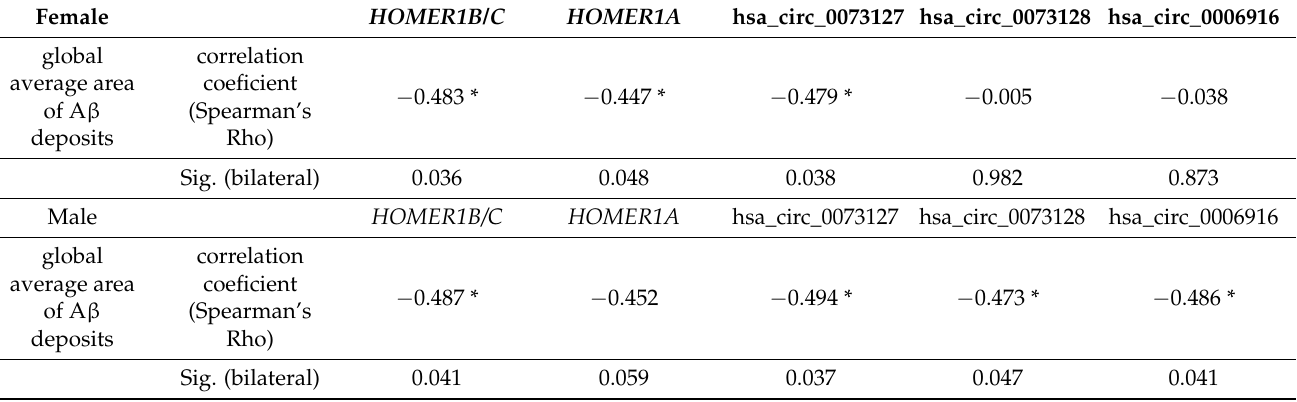
Table 2. Correlation between global average area of A β deposits and HOMER1 linear RNAs and circRNAs expression levels. ( n = 20). * p -value <